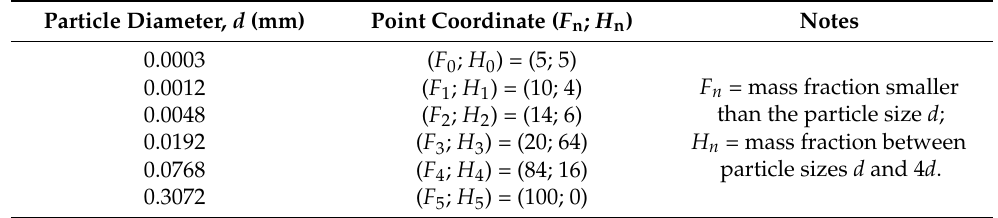
Table 3. F n and H n point